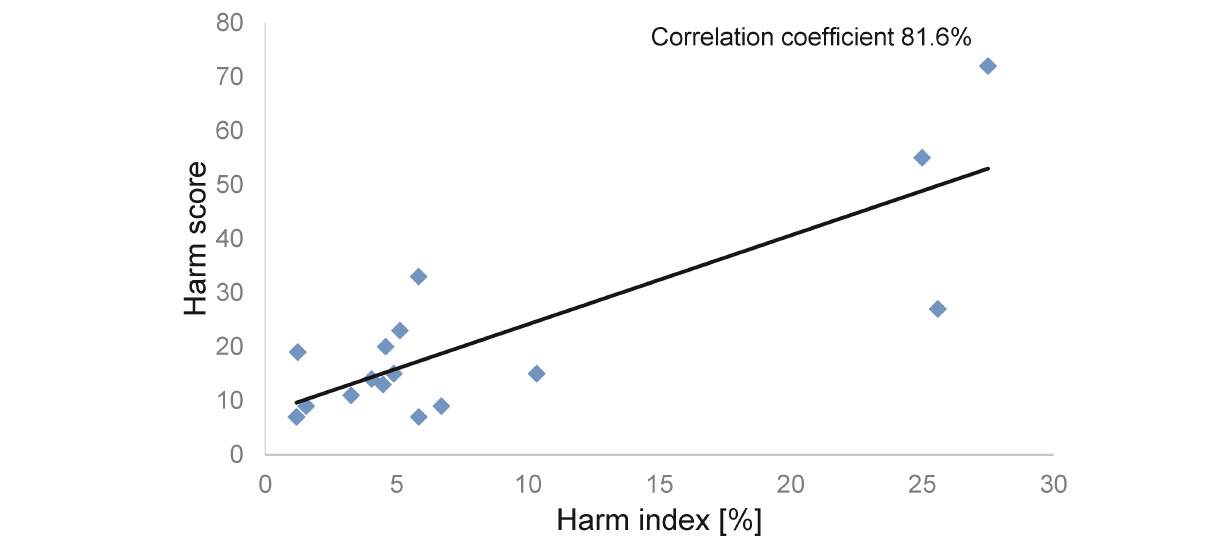
Figure 1. Correlation between harm scores obtained by Nutt et al [8] and the proposed harm index for a series of drugs identified by Google search (blue